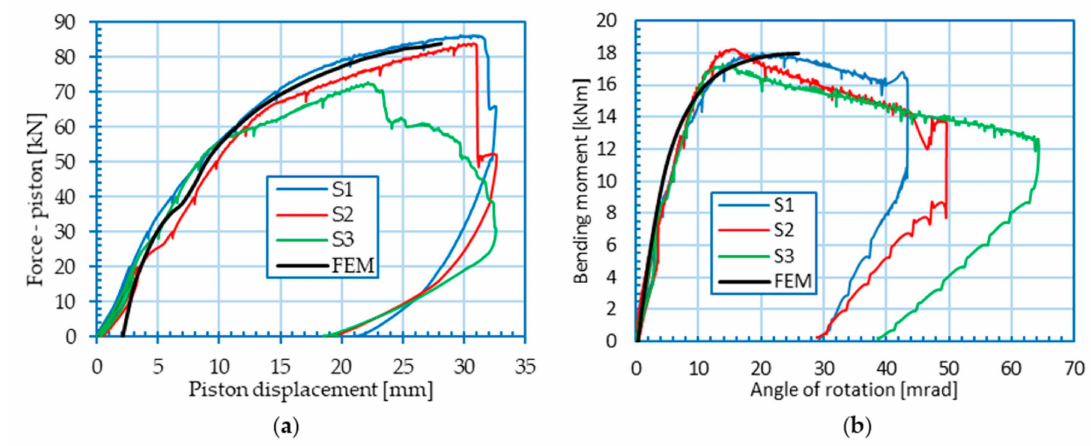
Figure 13. Comparison between experimental and numerical results: ( a ) load-displacement; ( b ) moment–rotation